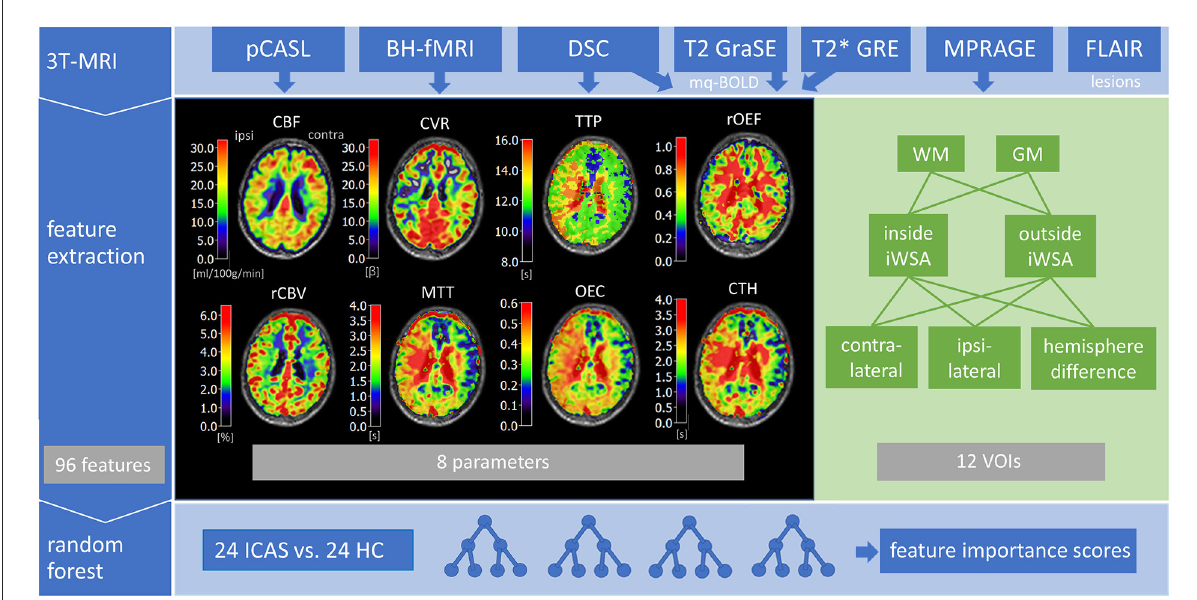
FIGURE1 Overview of included multi-parametric MRI data and major processing steps. The 3T-MRI comprised pseudo-continuous arterial spin labeling (pCASL) to obtain cerebral blood flow (CBF), breath-holding fMRI (BH-fMRI) for cerebral vascular reactivity (CVR), dynamic susceptibility contrast (DSC) MRI to measure time to peak (TTP), relative cerebral blood volume (rCBV), mean transit time (MTT), oxygen extraction capacity (OEC), and capillary transit-time heterogeneity (CTH), FLAIR to detect lesions and MP-RAGE to generate white matter (WM) and gray matter (GM) masks. Relative oxygen extraction fraction (rOEF) was modeled from quantitative transverse relaxation times T2 and T2 * as well as rCBV by multi-parametric quantitative blood oxygen level dependent (mq-BOLD) MRI. Next, mean parameter values were extracted from volumes-of-interest (VOIs) inside and outside of individual watershed areas (iWSA), additionally split in GM and WM, for both hemispheres and interhemispheric differences, resulting in 96 features overall. Finally, a random forest classifier was trained on data from 24 ICAS patients and 24 healthy controls (HC) to calculate feature importance